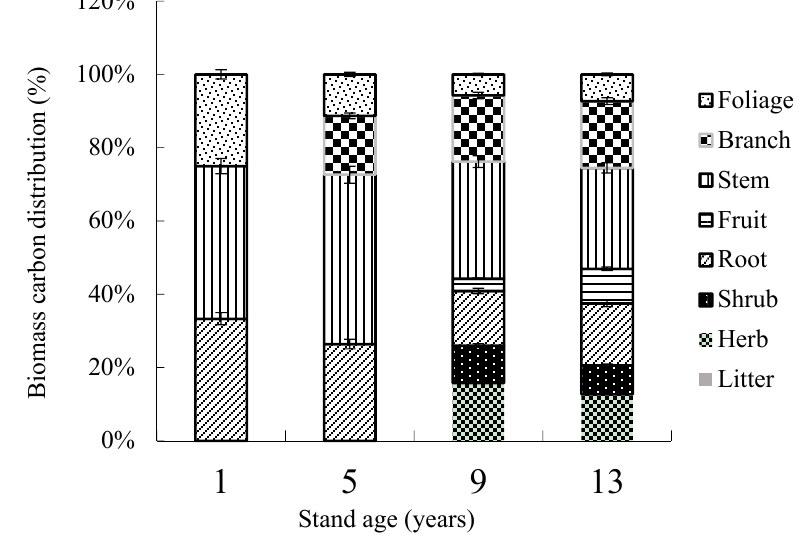
Figure 1. Percentage distribution of biomass C storage in J. regia plantations of four different ages.